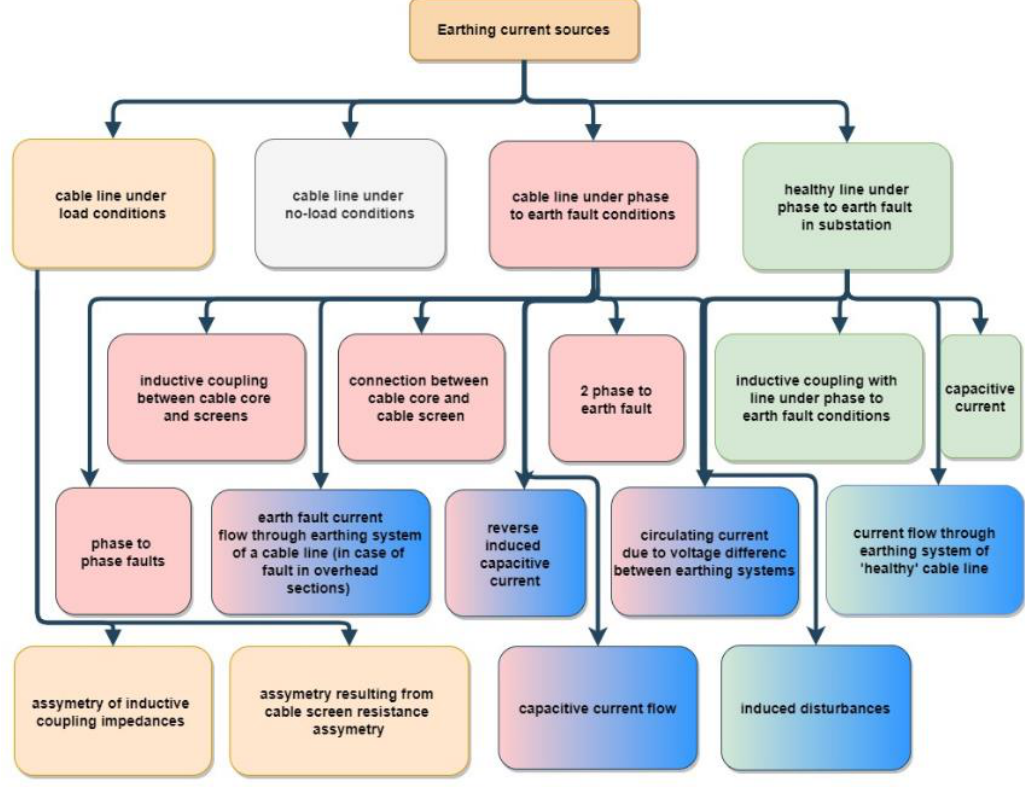
Figure 5. Earthing current sources.